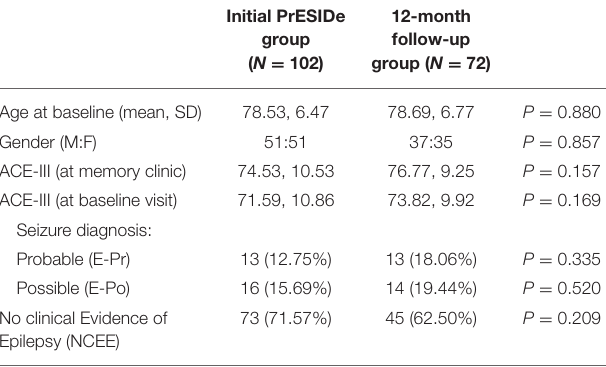
TABLE 2 | Comparing baseline characteristics of total PrESIDe group with group seen for 12-month follow-up.